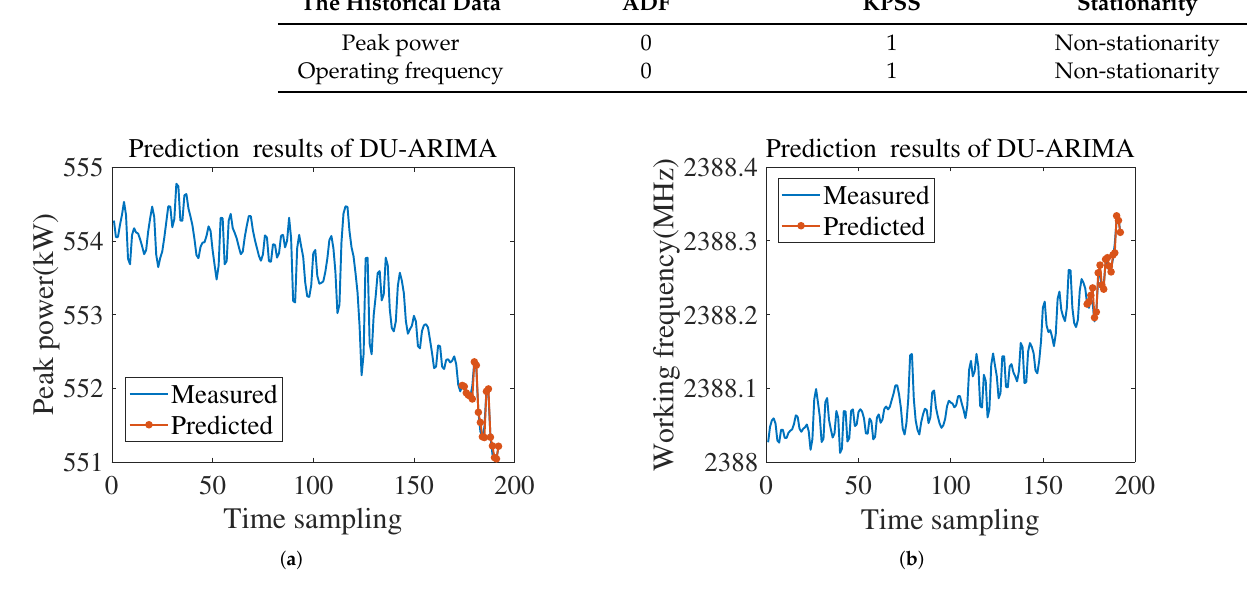
Figure 6. Monitoring data after denoising and prediction results of the first type of degradation malfunction. ( a ) Peak power. ( b ) Working frequency.